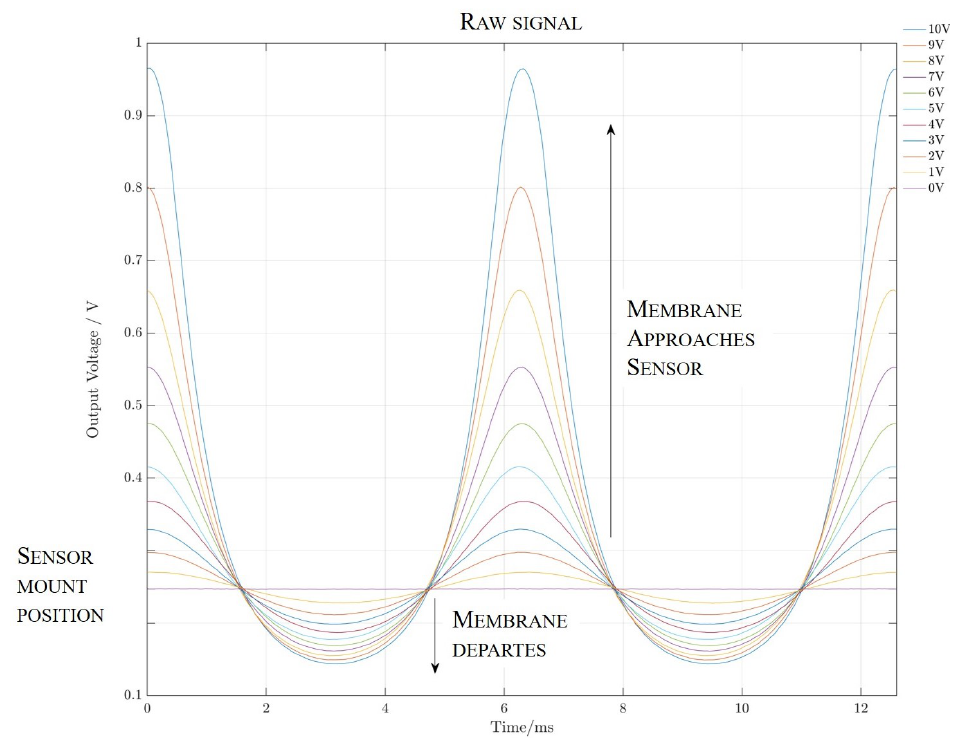
Figure 8. Raw measurement voltage signal.